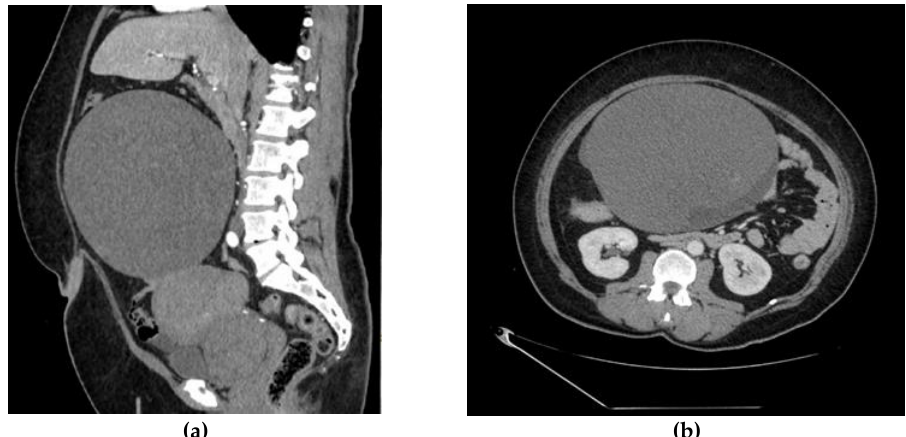
Figure 1. ( a ). Abdominal CT scan shows enlarged and deformed uterus, large (207 × 155 × 182 mm) thin-walled inhomogeneous tumor, connected to uterus and right ovary. ( b ). Abdominal CT scan shows multiple uterine myomas and a large (207 × 155 × 182 mm) thin-walled inhomogeneous tu-